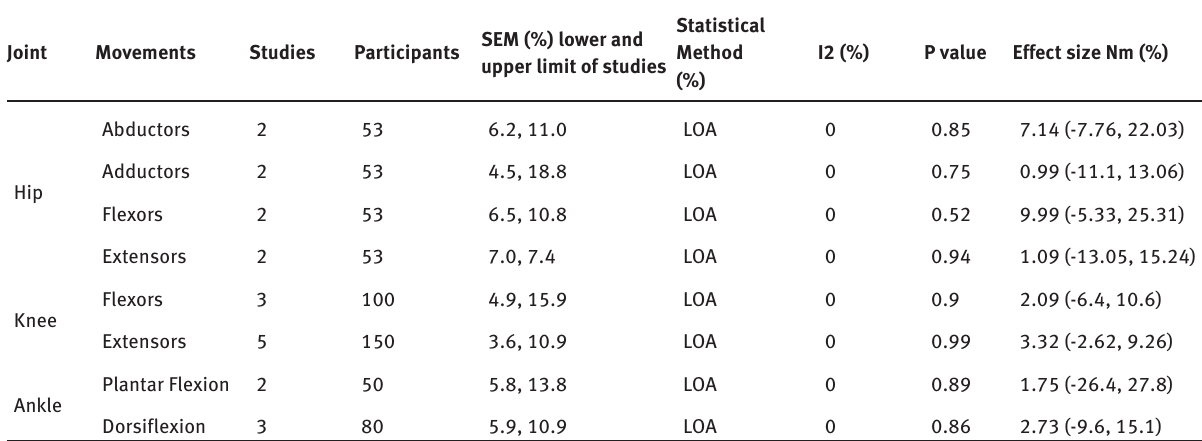
Table 8: Maximal voluntary isometric strength LOA for Inter-subject variability between trials: hip, knee, and ankle muscles measured with ID.